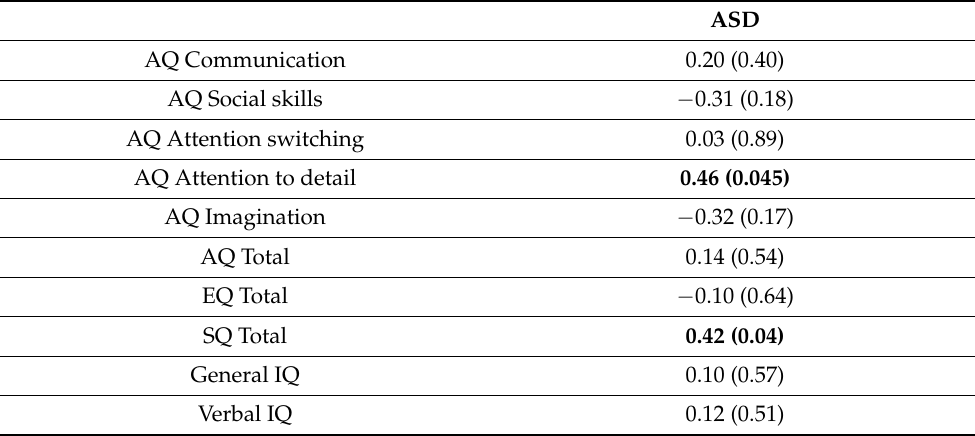
Table 3. Correlations a between HMGB1 serum concentrations and AQ b , EQ c , SQ d , and IQ scores in the total population and the ASD group.